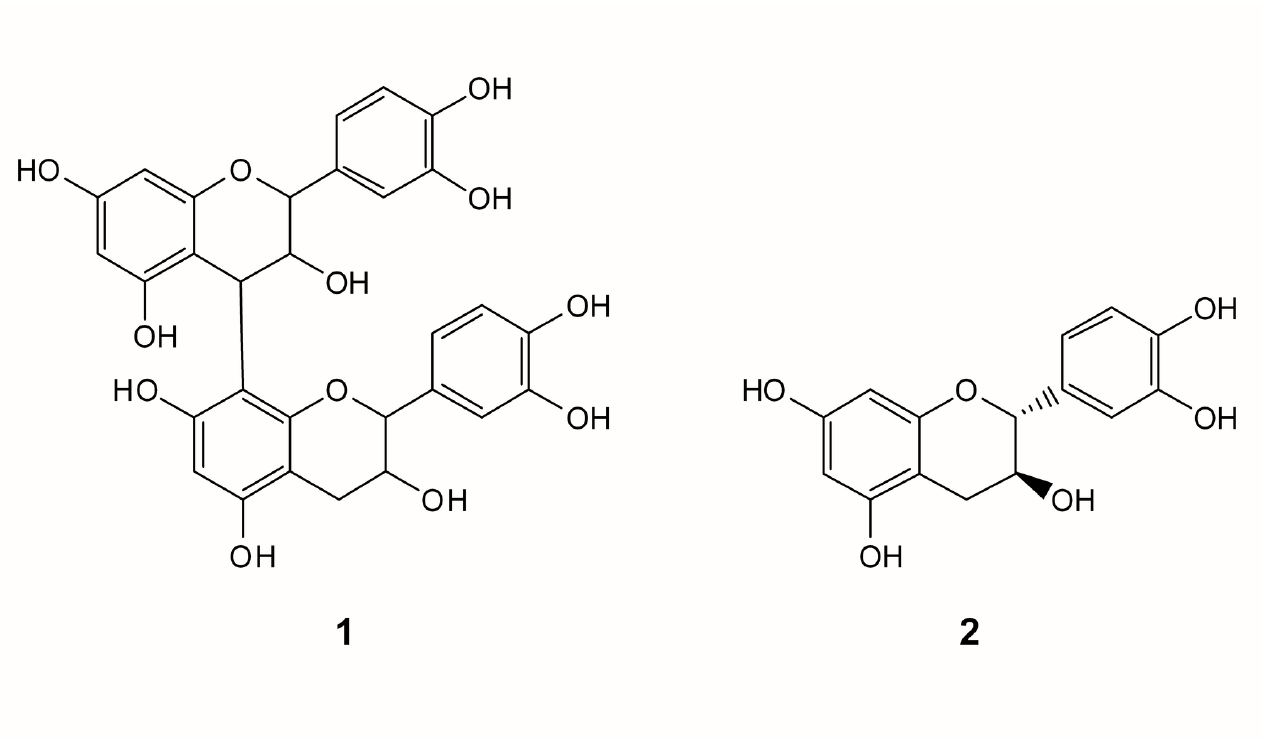
FIGURE 1 - Chemical structures of procyanidin (1) and catechin (2) identified in antibacterial fraction (F2) from leaves of P. spruceanum and subjected to in silico PASS online tool, to predict its action